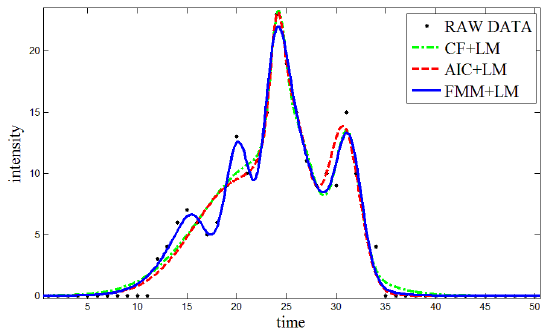
Figure 3. Waveform (simulated data) decomposition results based on three different methods